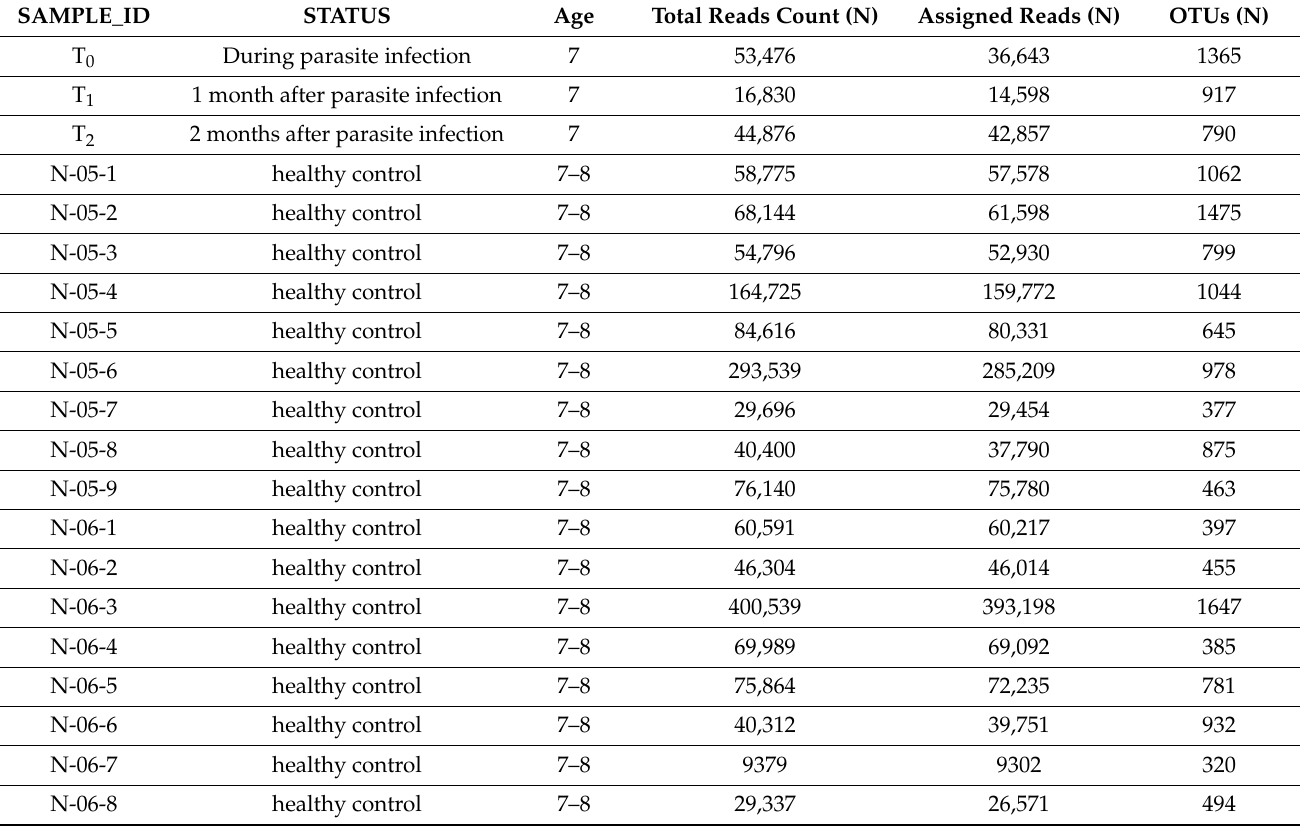
Table 1. Summary of the analyzed samples for the gut microbiota profiling and sequencing